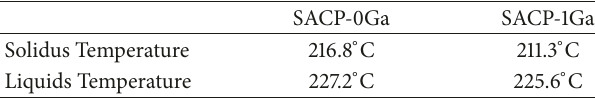
Table 2: Melting point of the SACP-xGa (T/ ∘